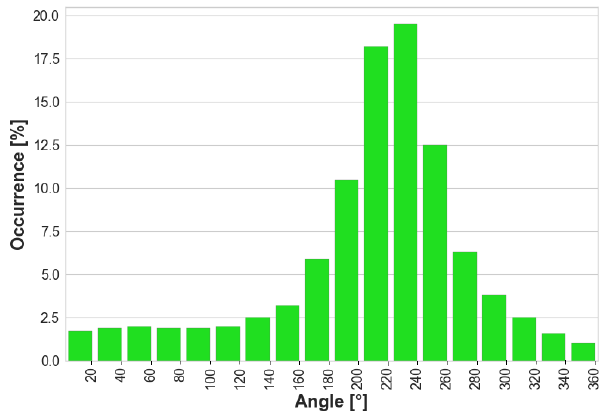
Figure 11. Same as Fig. 10 but for the mean